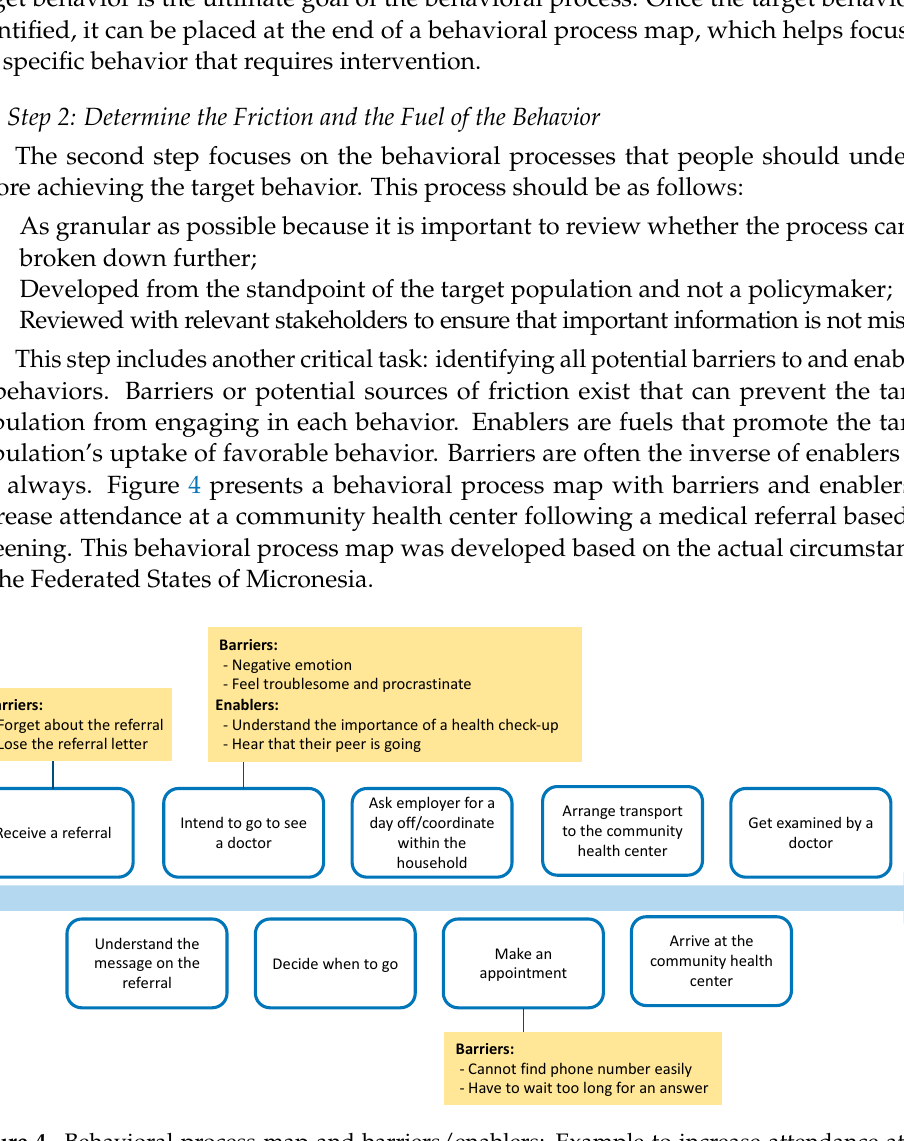
Figure 5. The EAST framework.